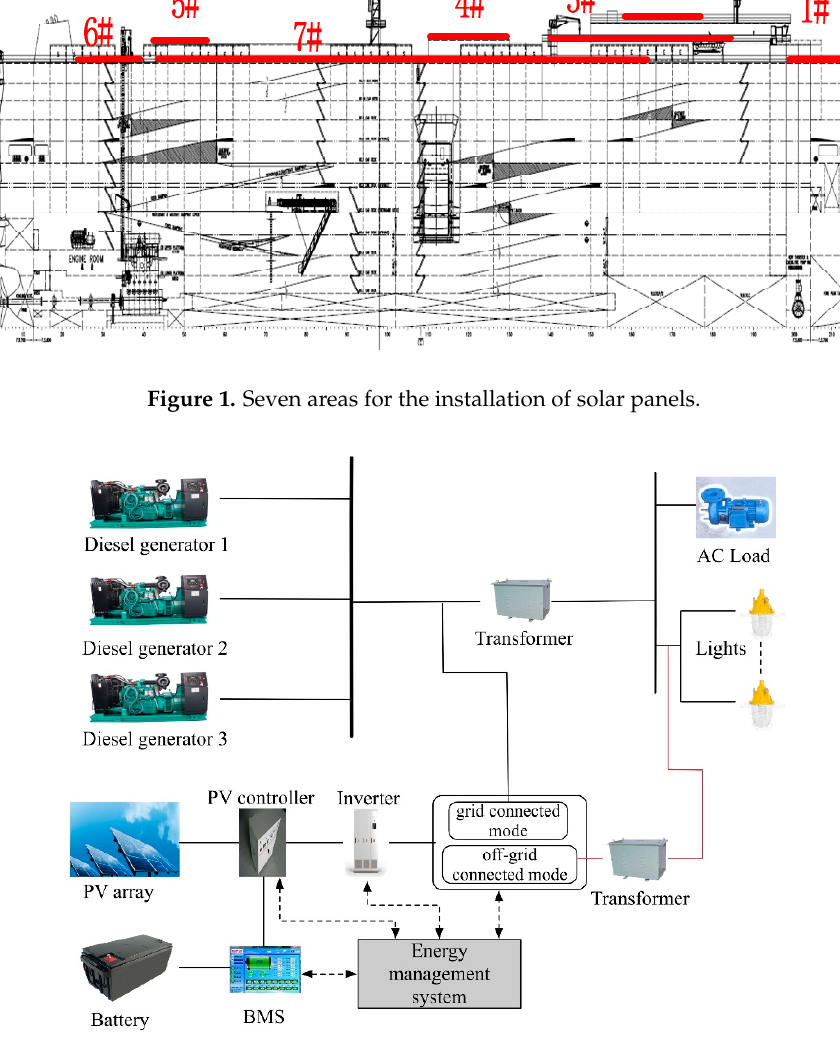
Figure 2. Overall structure of the unified stand along/grid-tied system.